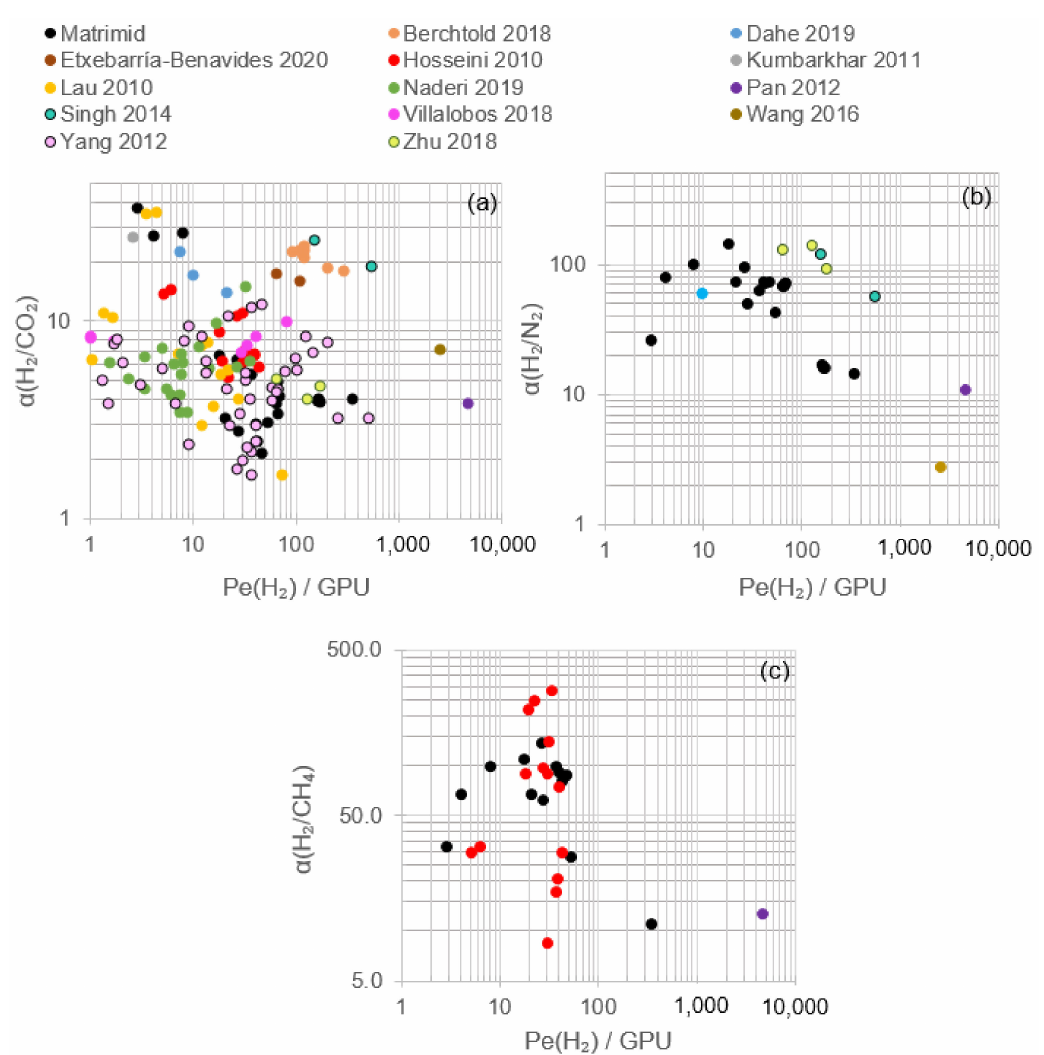
Figure 9. Hydrogen permeance values (GPU) and selectivities obtained for modified Matrimid ® HFMs: ( a ) H 2 /CO 2 , ( b ) H 2 /N 2 and ( c ) H 2 /CH 4 . Reference correspondence is found in Table